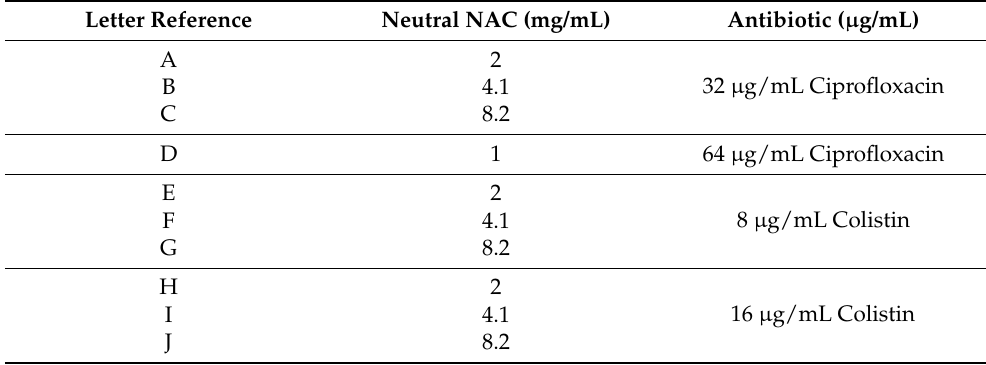
Table 2. Combination therapy (CT) used in study was derived from Aiyer et al. (2021) [6] and was based on a synergy fractional inhibitory concentration index checkerboard